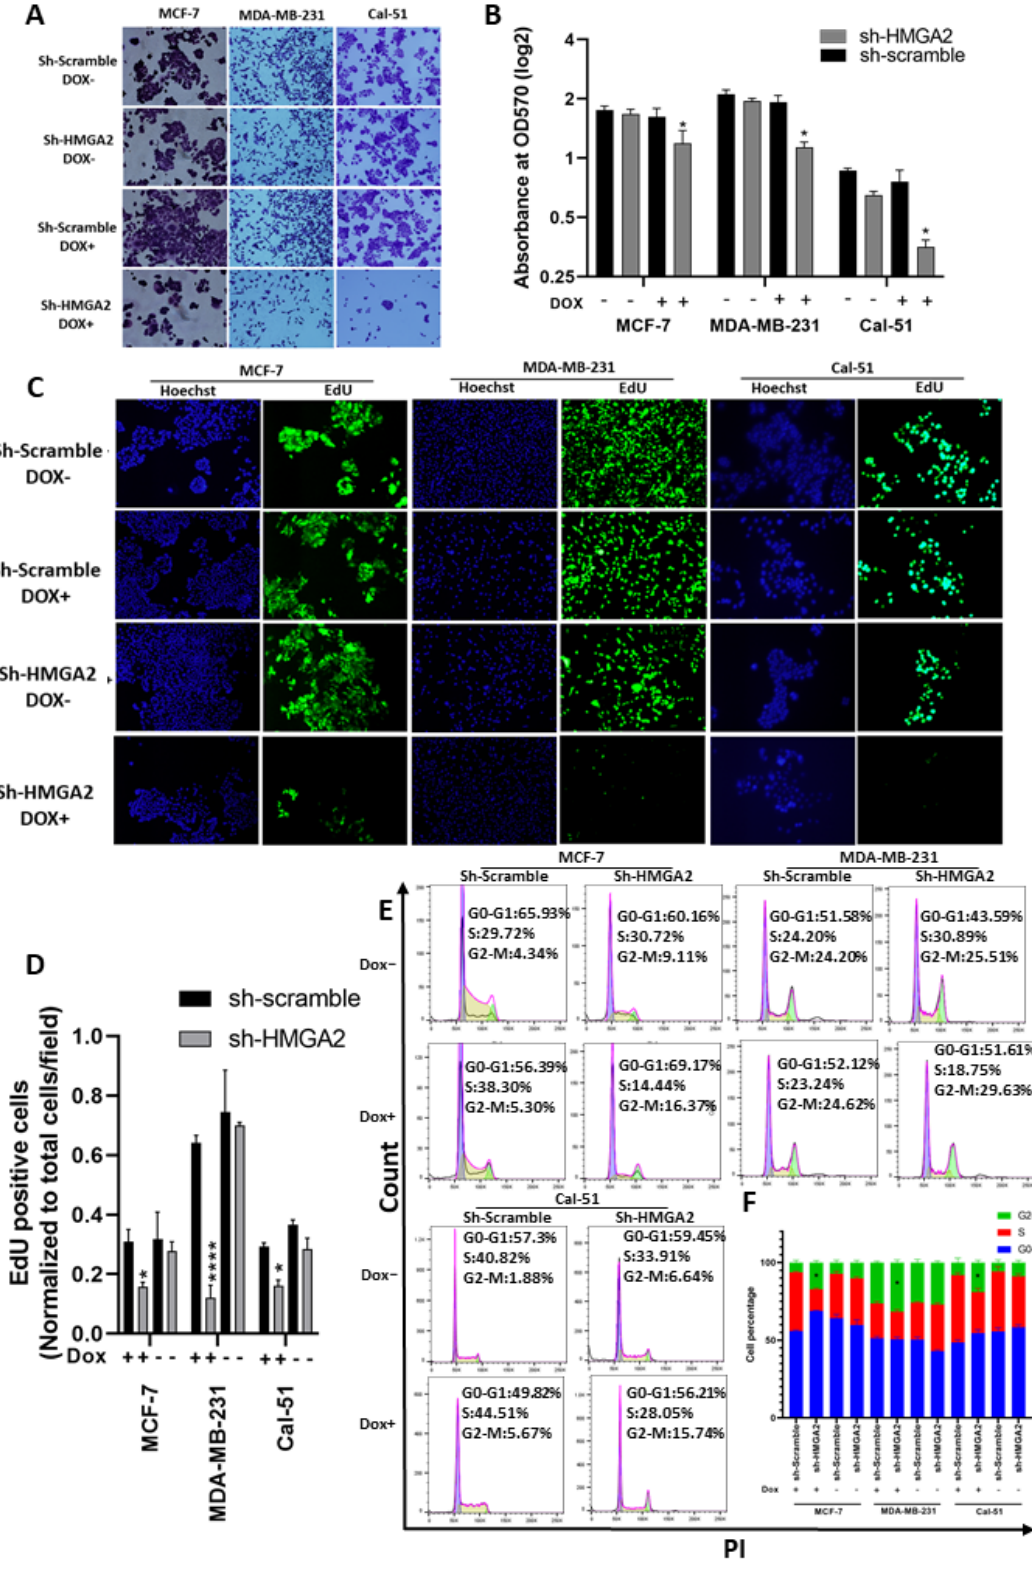
Figure 3. HMGA2 silencing decreased TNBC proliferation and G2-M arrest. Crystal violet proliferation assay showed a significant reduction in the number and optical density (570 nm) in the HMGA2-silenced (shHMGA2) compared to scrambled control (shScrambled) transduced cells ( A , B ). In addition, HMGA2 silencing caused a significant reduction in